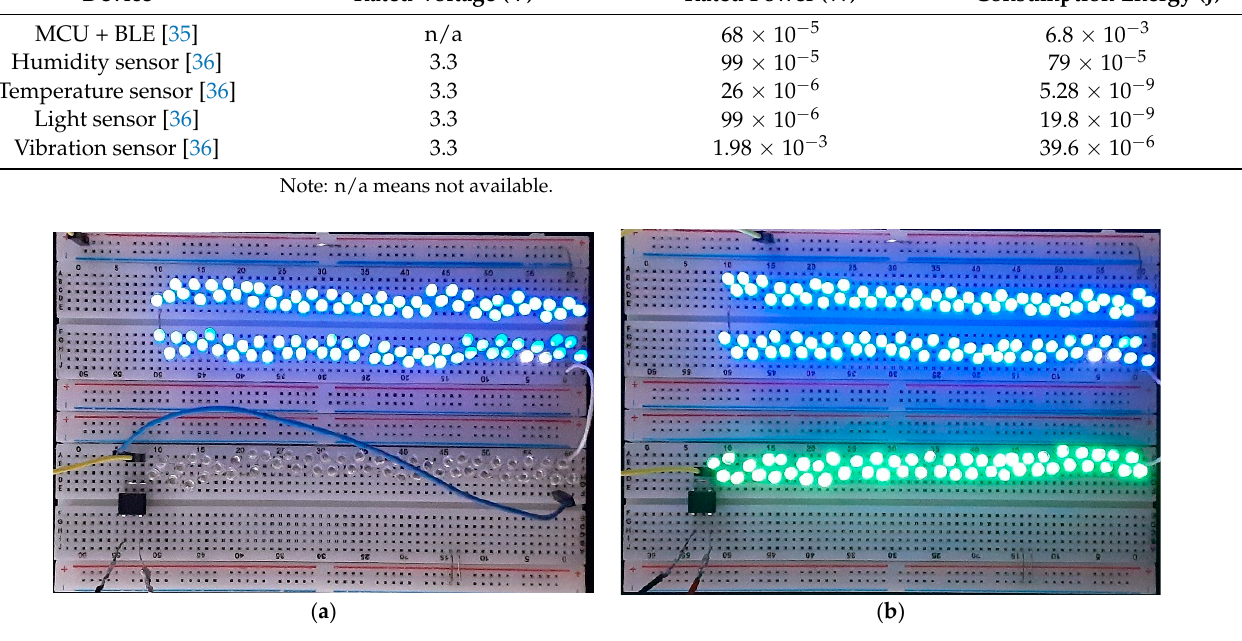
Figure 11. LED load connected to TEHFT: ( a ) TEHFT with 0.1 mm thick PTFE film; ( b ) TEHFT with 0.2 mm thick PTFE